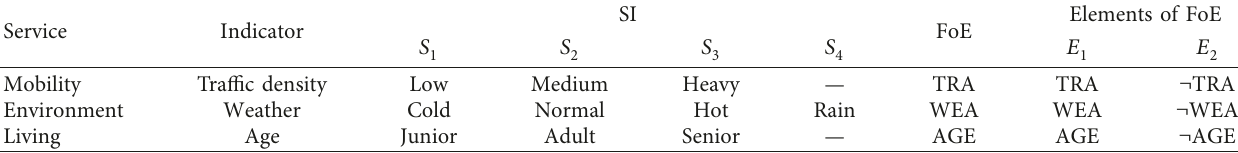
Table 1: Frames of evidence (FoE) of outside sensory information (SI).